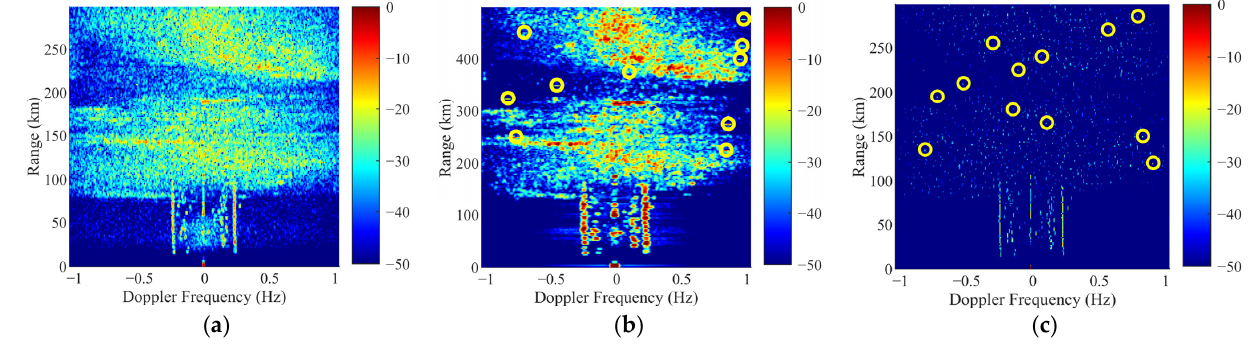
Figure 10. The suppression results of spread F-region ionosphere clutter. ( a ) Original RD images; ( b ) the suppression results of the method proposed by Su et al.; ( c ) the suppression results of the proposed methodology.